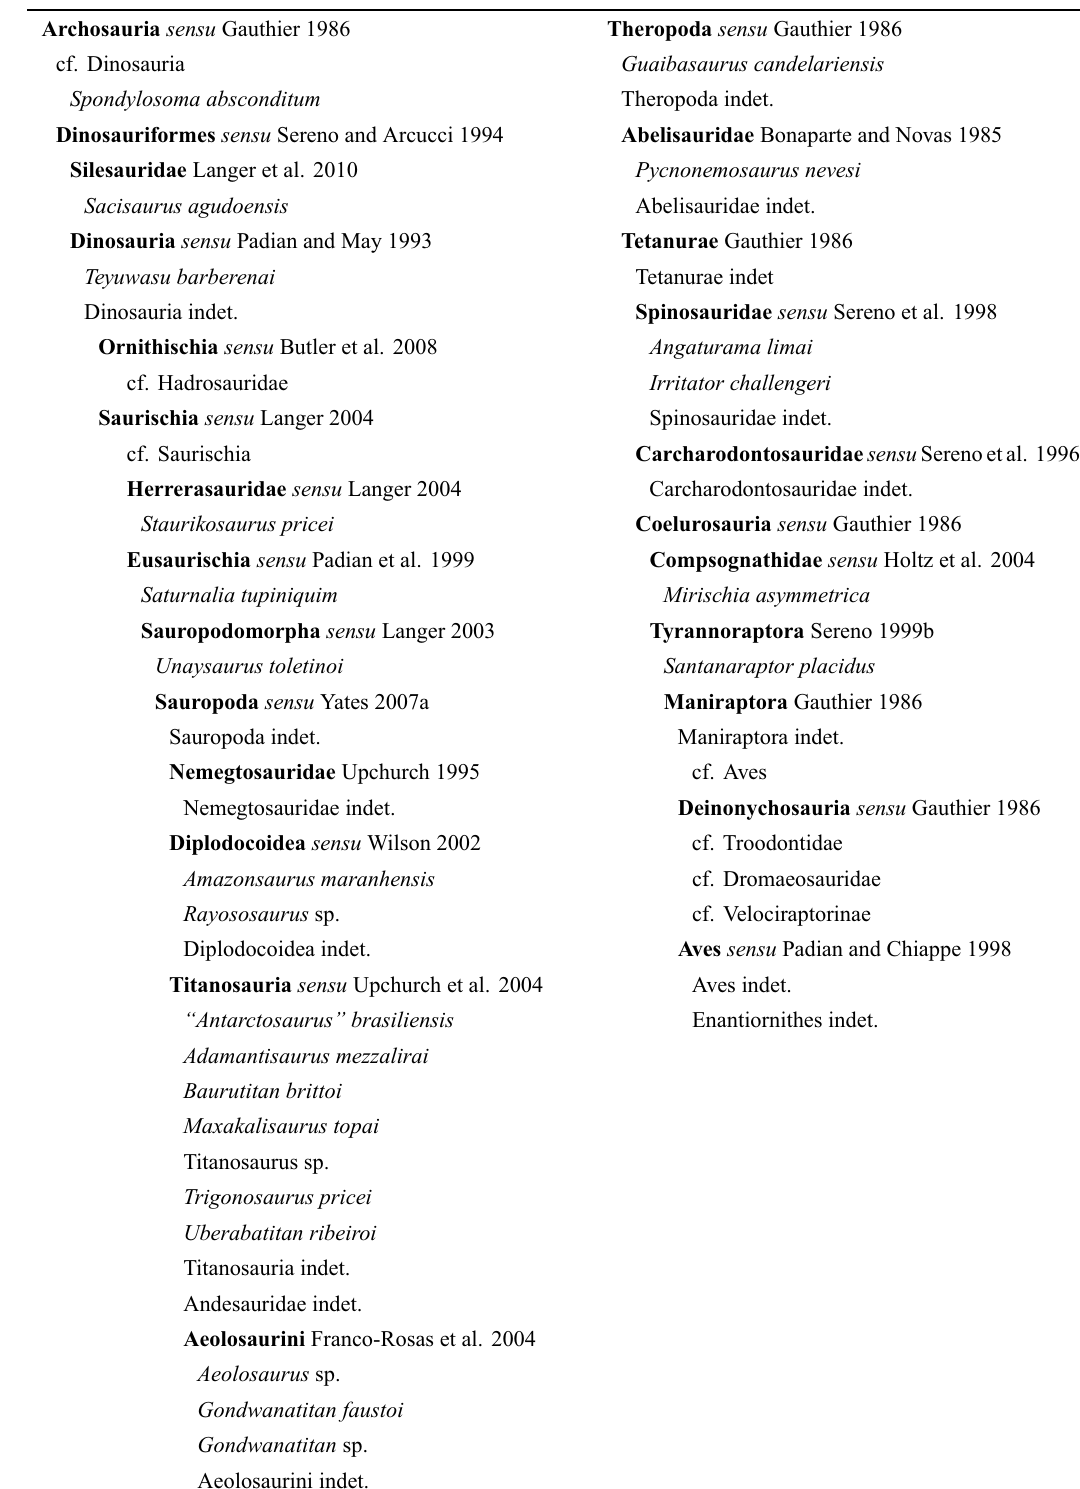
List of Mesozoic dinosauriform taxa recorded in Brazil indented by taxonomic